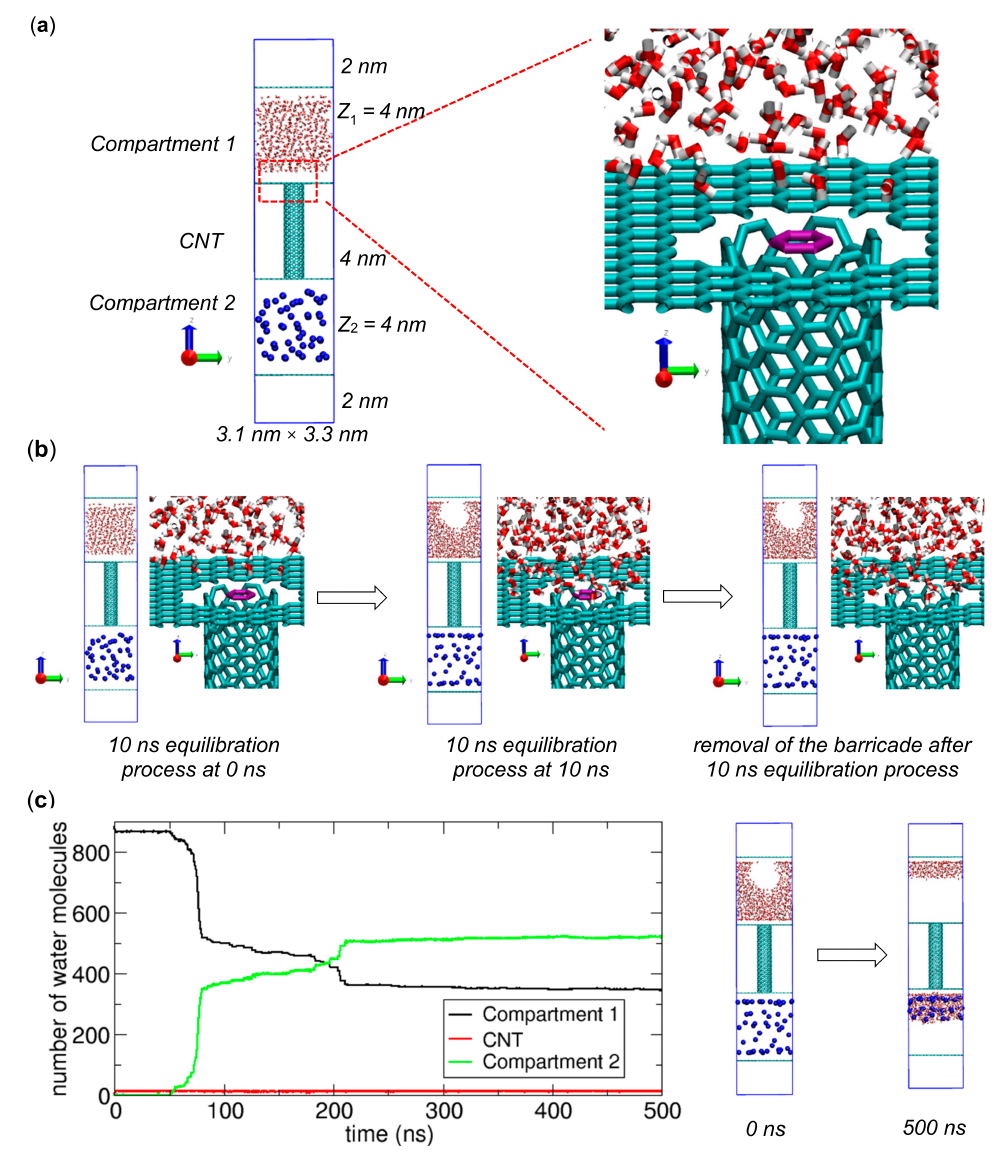
Figure 1. Simulation of water molecule transport from a compartment filled with water molecules (Compartment 1) to another spacious compartment (Compartment 2) through a carbon nanotube (CNT) in the presence of 50 osmolytes with IS WO = 10. Here, osmolytes are represented by blue spheres. ( a ) Initial configuration of the system, in which all water molecules are in Compartment 1 (left), and a zoomed-in view around the boundary between Compartment 1 and the CNT (right), where a molecular barricade, i.e., a six-carbon ring (violet), is located at a fixed position on the boundary. From the zoomed-in view, a gap appears to exist between the CNT and the graphene with a hole such that water might pass through it, but in reality, the gap is too small for water to pass through it. Note that the blue lines indicate the periodic boundary of the system. ( b ) Configurations at 0 ns (left) and 10 ns (center) from the 10 ns equilibration process in the presence of the barricade (violet), and the configuration (right) in which the six-carbon ring has been removed after the equilibration process. The last configuration is used for the simulation of water transport. ( c ) Numbers of water molecules in Compartment 1 (black), the CNT (red), and Compartment 2 (green) during a transport process (left) along with MD simulation snapshots at 0 and 500 ns